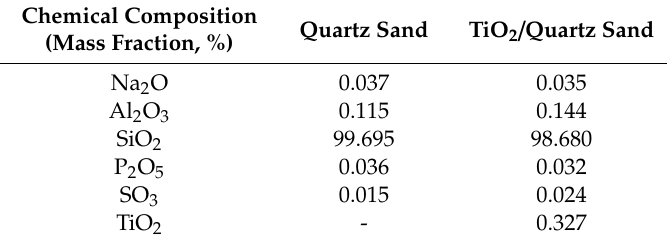
Figure 2. X-ray di ff raction (XRD) patterns of quartz sand, TiO 2 / quartz sand and pure TiO 2 . Figure 2. X-ray diffraction (XRD) patterns of quartz sand, TiO 2 /quartz sand and pure TiO 2 . Table 1. Chemical compositions of quartz sand and TiO 2 / quartz Table 1. Chemical compositions of quartz sand and TiO 2 /quartz sand.